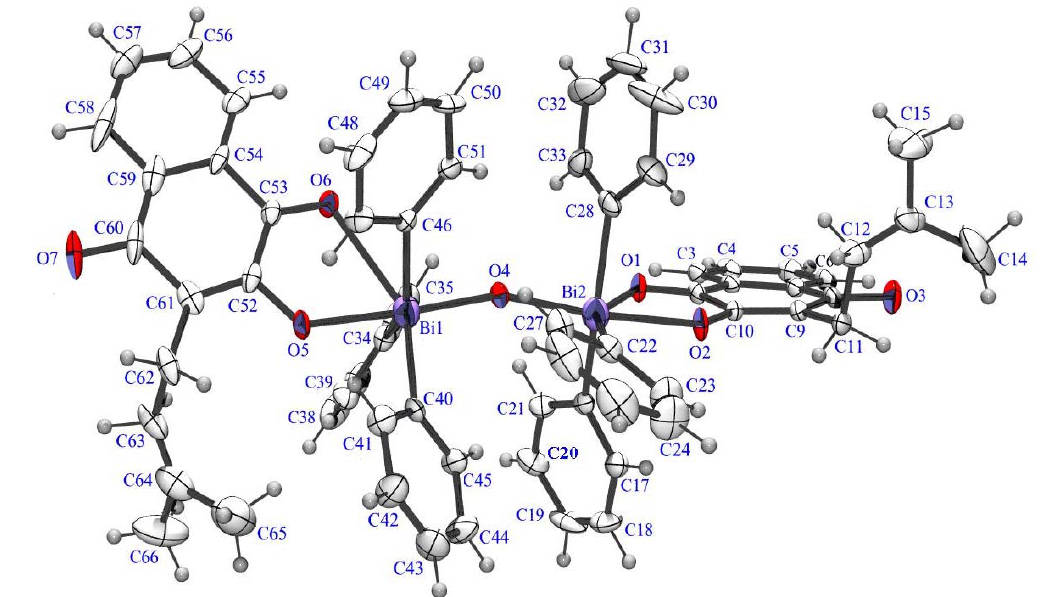
Figure 3. An ORTEP-3 projection of compound 3 showing the atom-numbering and displacement ellipsoids at the 30% probability level.